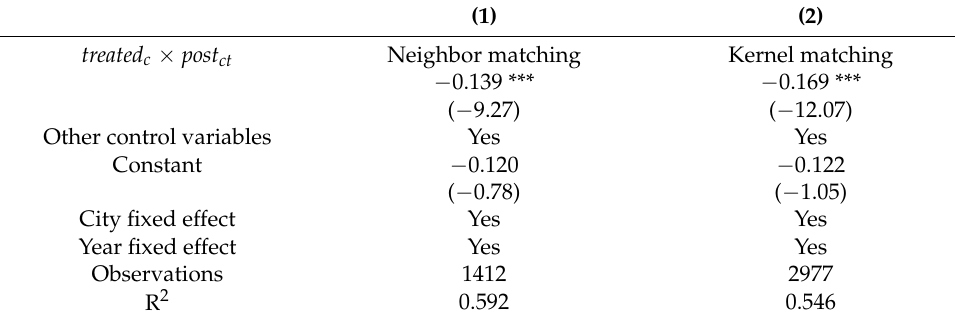
Table 6. Estimation results of PSM-DID.